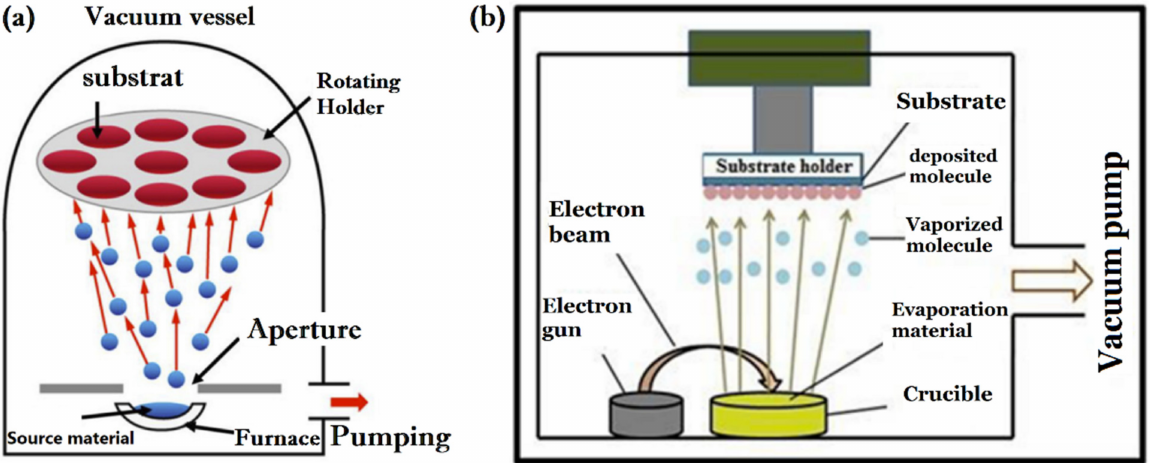
Figure 4. Schematic of thermal evaporation. ( a ) Resistive thermal evaporation. ( b ) Electron-beam evaporation. Reprinted with permission from